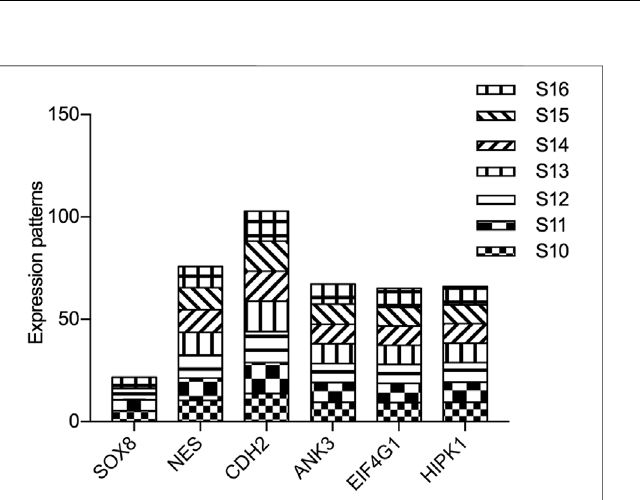
FIGURE 10 | Expression of candidate genes in human embryonic heart. The expression patterns of candidate genes in human embryonic heart at differentstages ofS10toS16wereanalyzedbymicroarray.X-axis represents thedifferentstagesofhumanembryonicheart,whiletheY-axisindicates the level of gene